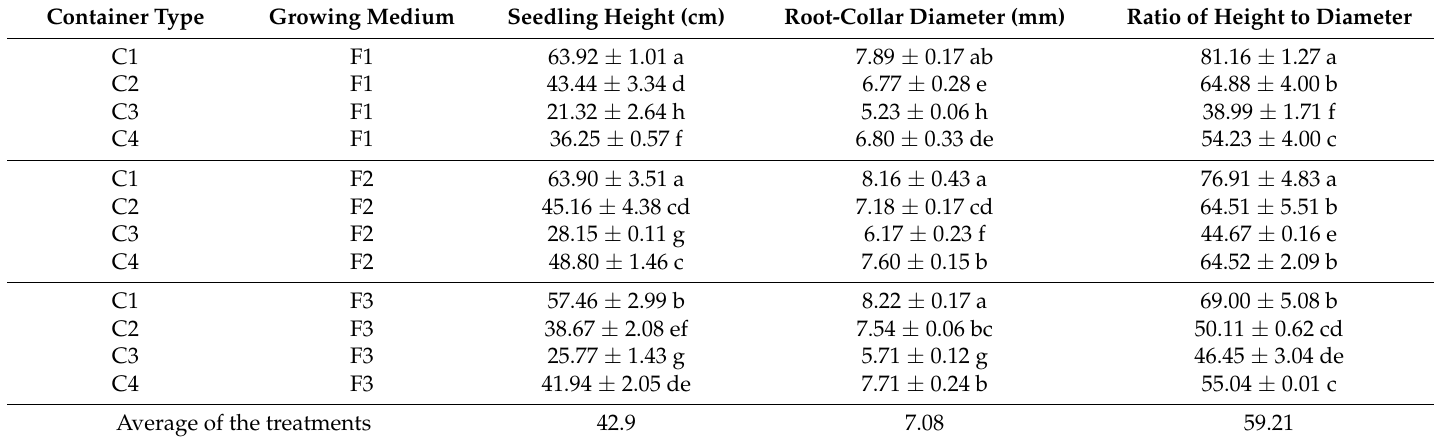
Table 3. Effects of container type and growth medium on height growth, root-collar diameter, and the ratio of height to diameter of Cyclocarya paliurus container